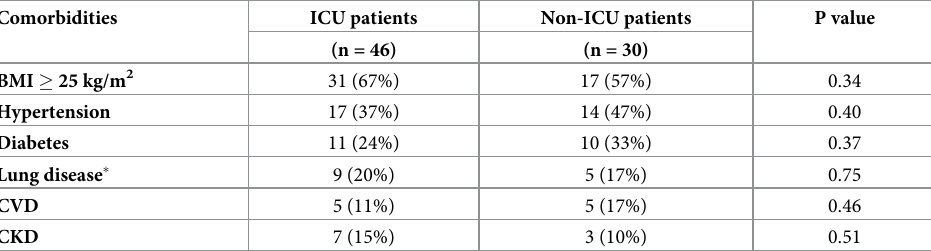
Abbreviations: BMI, body mass index; CVD, cardiovascular disease; CKD, chronic kidney disease. � Patients with background of lung disease had one of the following: Chronic obstructive pulmonary disease (COPD), Obstructive sleep apnoea (OSA), interstitial lung disease (ILD) and Asthma (moderate and